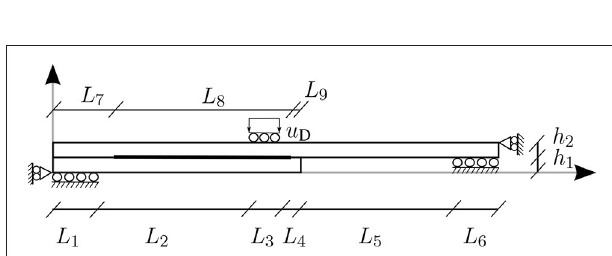
FIGURE 9 | Representation of the receding problem studied: Two beams in contact, (cid:127) 1 and (cid:127) 2 , subjected to